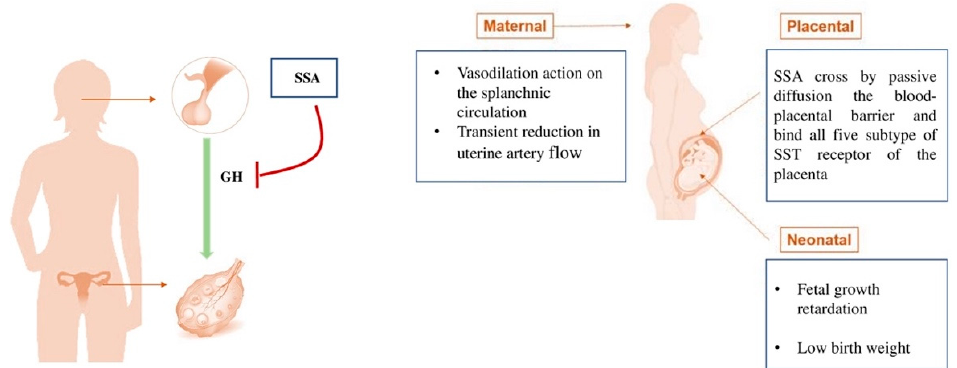
Figure 2. Hypothesis of SSA role in female fertility and pregnancy. SSA could cause a reduction in GH secretion with a negative impact on the growth and onset of fertility. SSA could induce maternal, placental and potentially relevant neonatal effects (as fetal growth retardation and low birth weight). SSA = Somatostatin analogues; GH = Growth hormone.